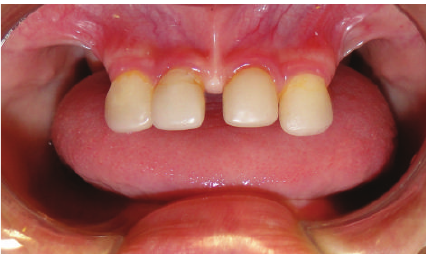
Figure 1: Initial intraoral view showing the maxillary incisors.